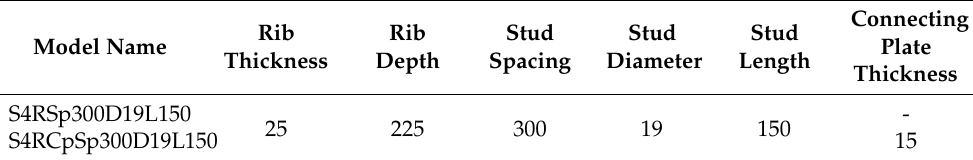
Table 3. List of finite-element models with rib plate and shear stud